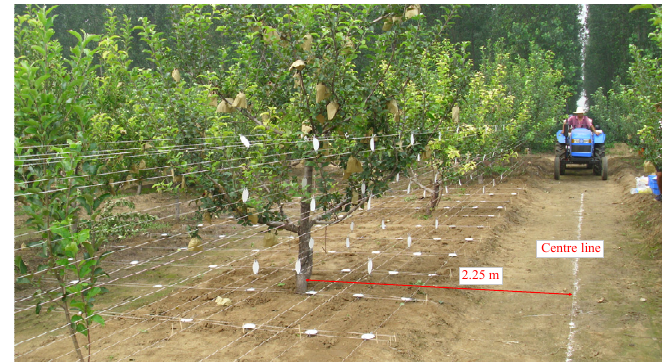
Figure 8. Spray experiment scheme. Table 2. The key parameters of the experiment.